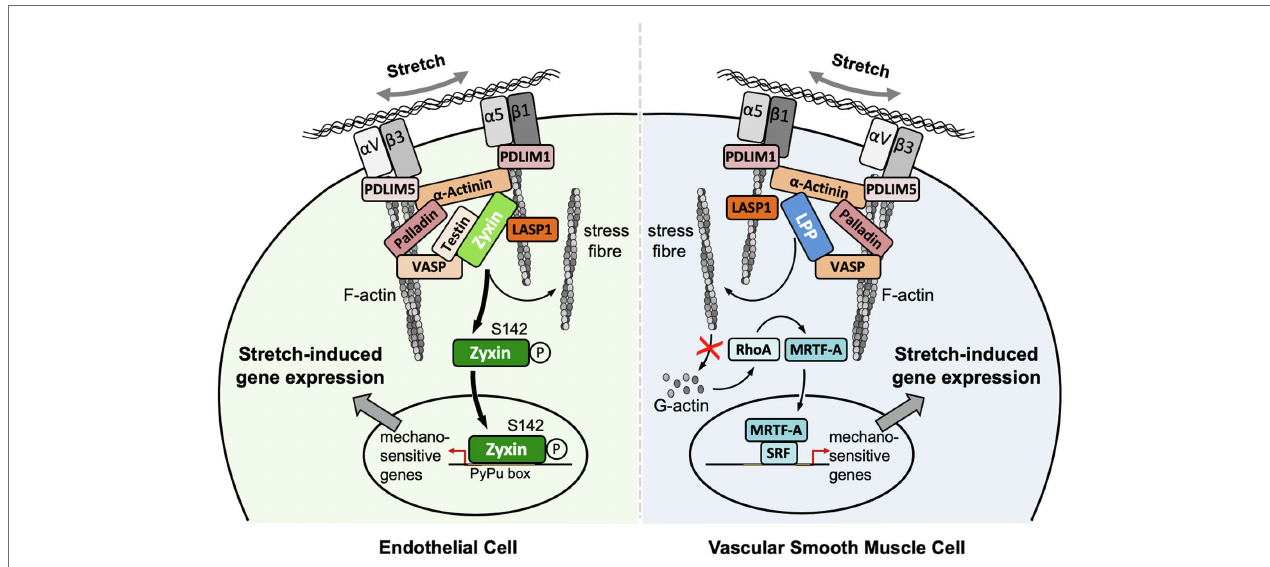
FIGURE 1 | Localization and putative mechanisms of action of zyxin in EC and LPP in vascular SMC. Note that the putative mechanism of action of LPP is derived from our findings on the mechanism of action of zyxin in vascular SMC. Both LIM domain proteins seem to serve the same function in vascular SMC, that is, to maintain their quiescent contractile phenotype. Note that there is no LPP expression in adult EC of mouse or human origin. α V β 3 and α 5 β 1, corresponding integrins; LASP1, LIM and SH3 domain protein 1; MRTF-A, myocardin-related transcription factor A; PDLIM1, PDZ and LIM domain protein 1; PDLIM5, PDZ and LIM domain protein 5; SRF, serum response factor.